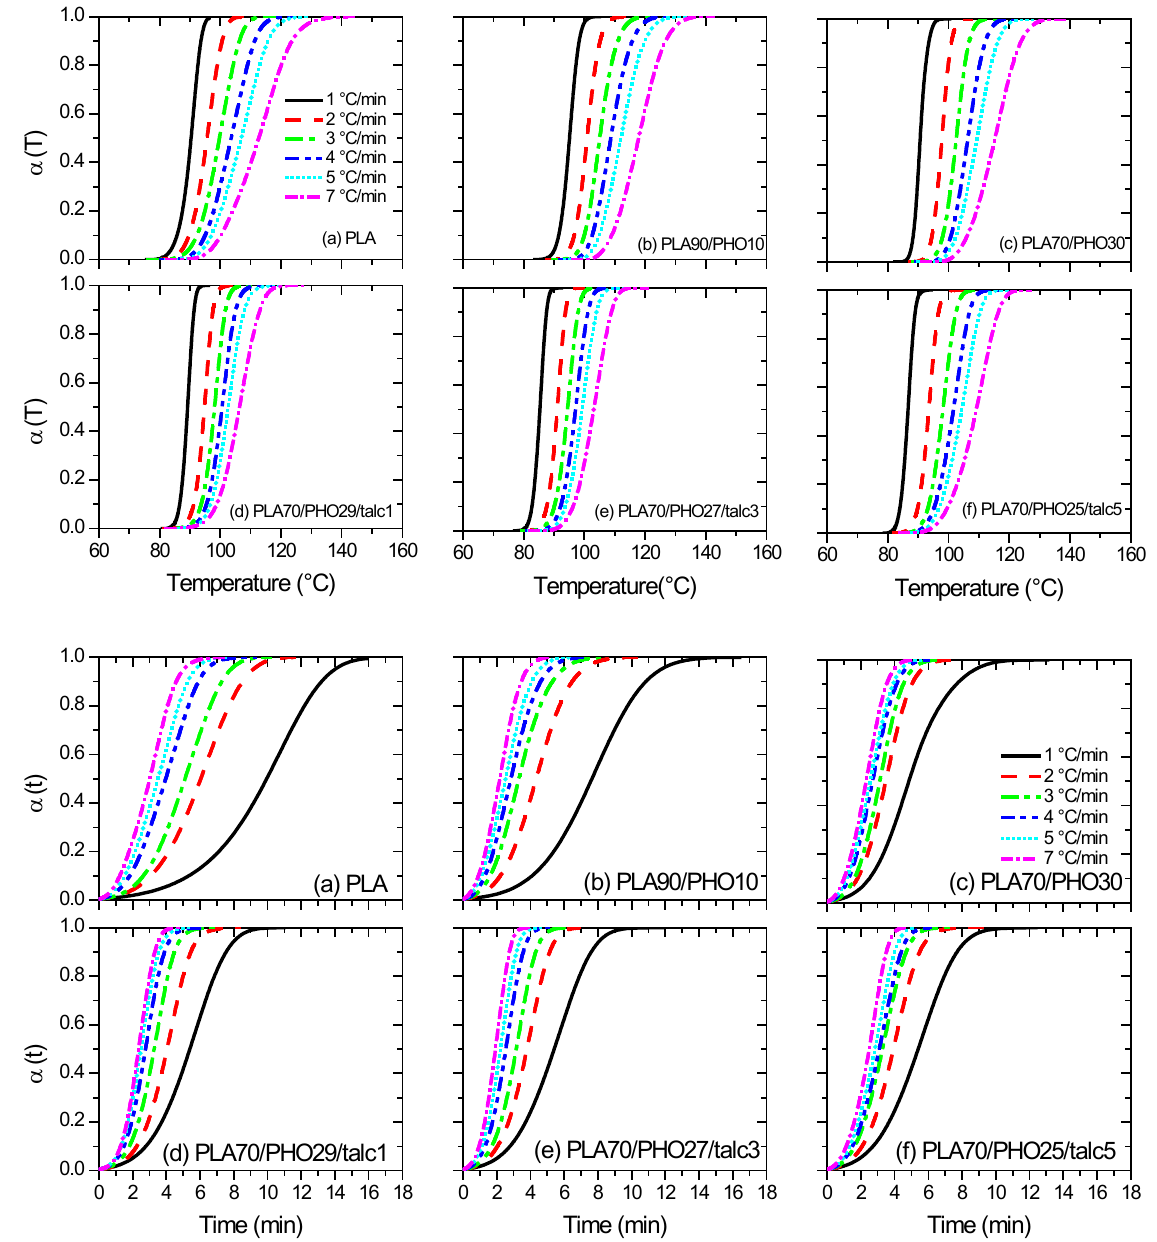
Figure 3: α(T) and α(t) as a function of temperature and time, respectively, at different heating rates and